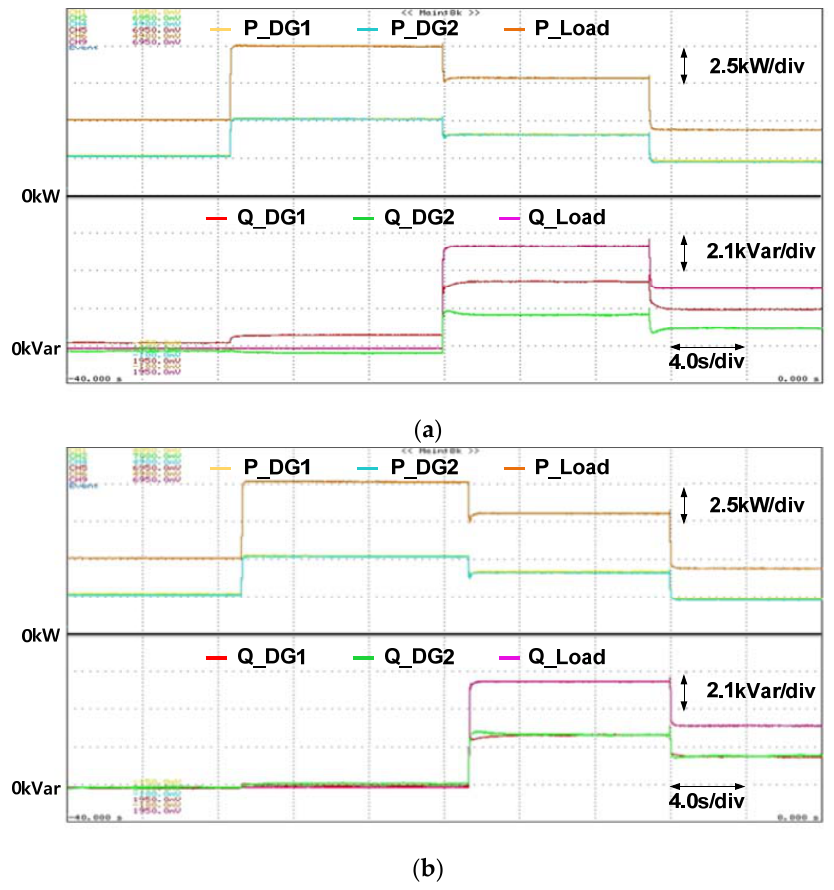
Figure 20. Experimental results of active and reactive power for Case 2: ( a ) Existing droop; ( b ) Proposed droop.